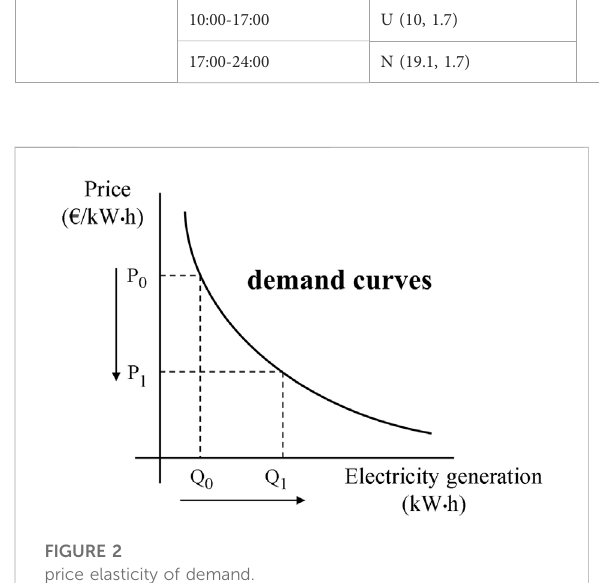
FIGURE 2 price elasticity of